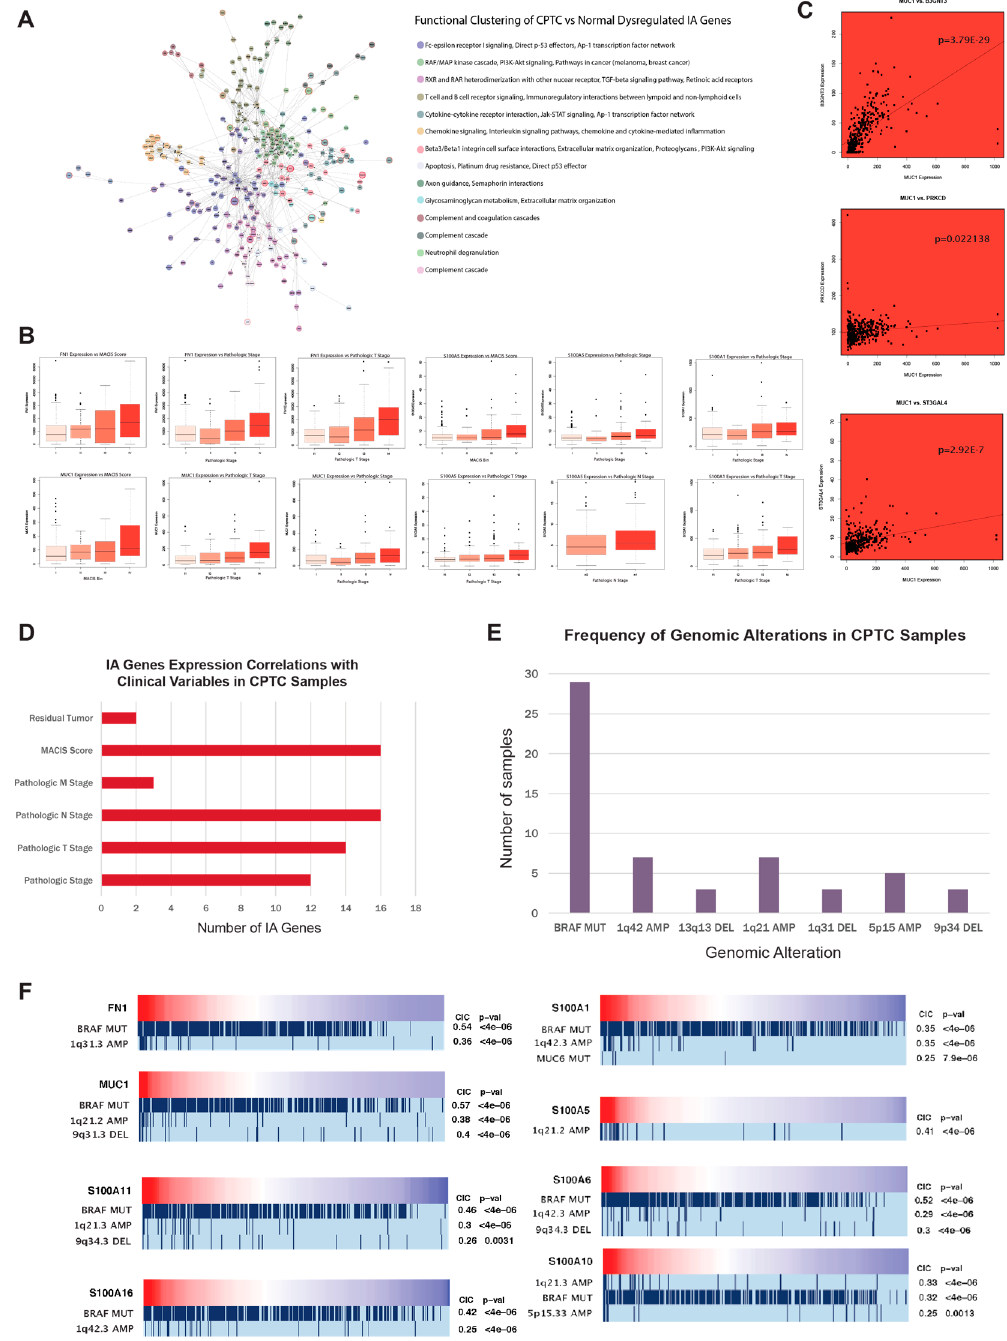
Figure 2. Pathways and genes characterizing the CPTC dysregulation landscape. ( A ) ReactomeFIViz functional clustering analysis for dysregulated genes in CPTC vs normal samples. CA or IA gene nodes are distinguished by black text and red or blue outlines, with red signifying gene upregulation and blue signifying gene downregulation in CPTC. Node size correlates with larger absolute logFC. Edges of the plots were determined by Functional Interaction (FI) score visualization. ( B ) Boxplots presenting association of dysregulated genes’ expression with clinical variables for CPTC patients. ( C ) Scatterplots correlating expression of MUC1 to that of related genes. ( D ) Barplot documenting number of CA / IA genes that correlated with six clinical variables. ( E ) Barplot depicting number of samples that possess the most common genomic alterations. ( F ) REVEALER plots illustrating genomic alteration associated with dysregulated genes. The REVEALER analysis was conducted using CPTC samples only.